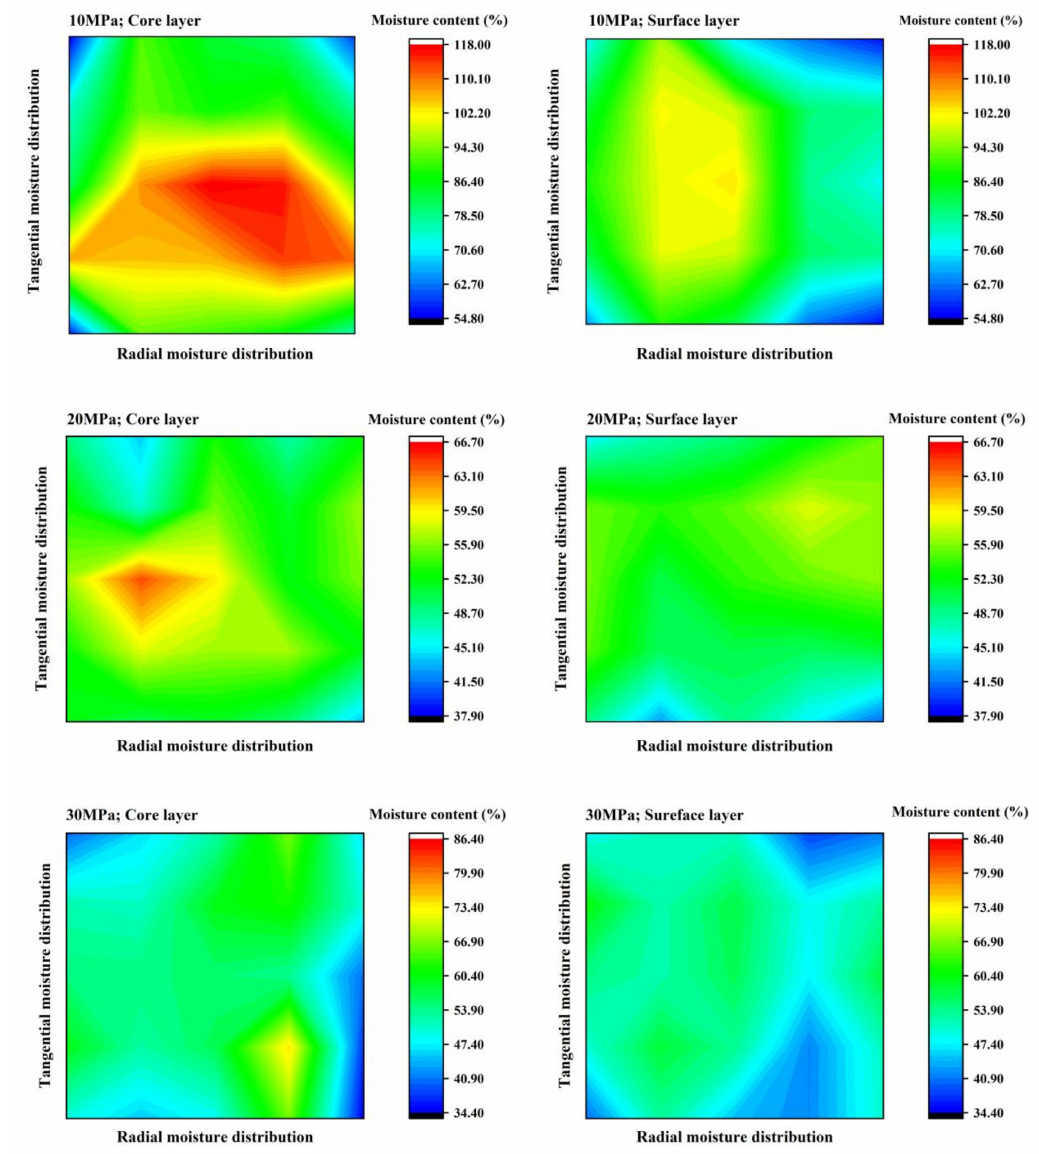
Figure 5. Moisture content distribution of wood after 1 h of SCD at di ff erent pressures (core layer: the slice in the middle of a specimen; surface layer: the slice near one end of a